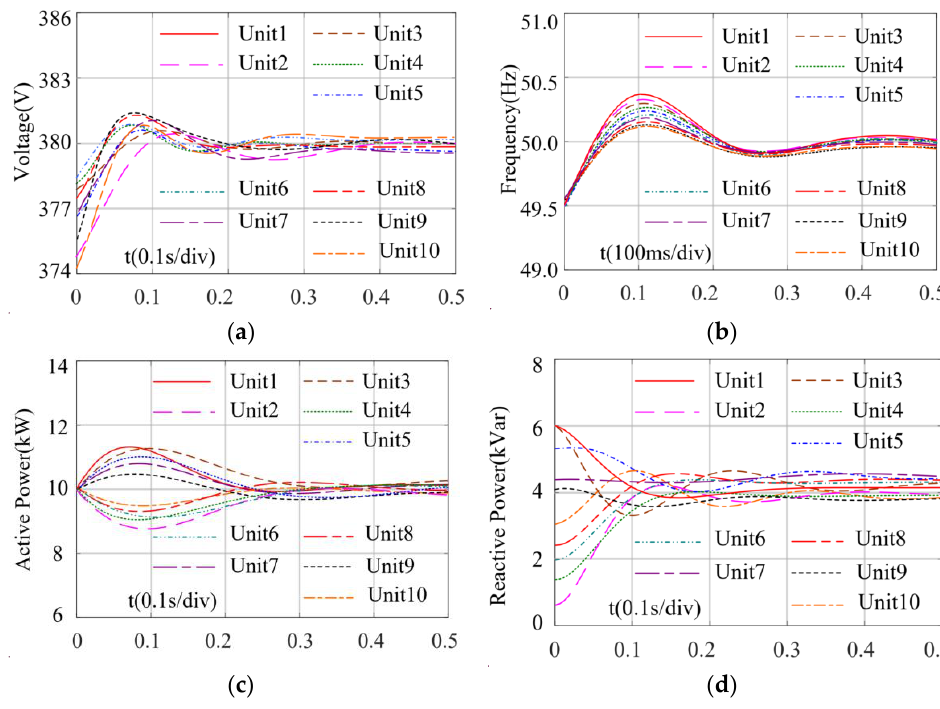
Figure 8. The simulation waveforms with the control strategy in [22]. ( a ) voltage amplitude;( b ) frequency;( c ) active power;( d ) reactive power.